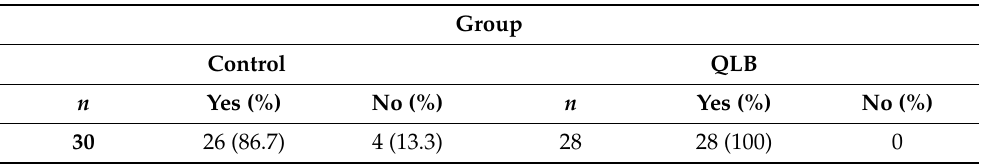
Table 4. Answer to question no. 1 from the survey. Are you satisfied with the pain management after the cesarean section for the first two